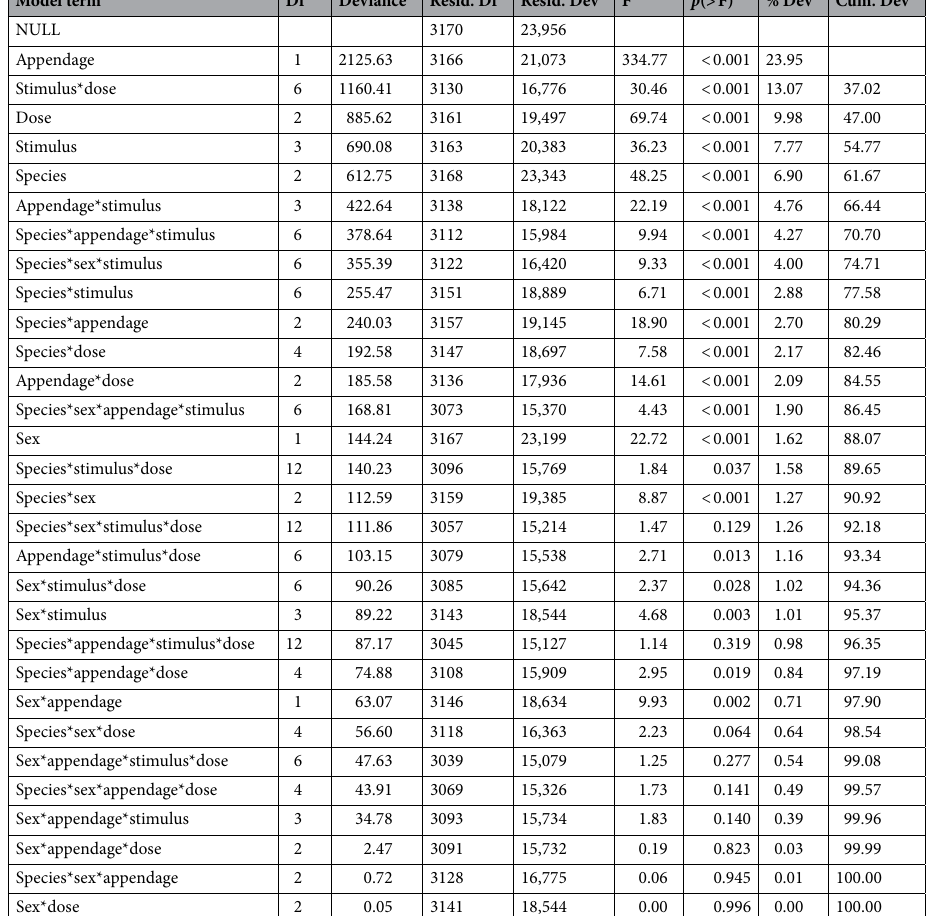
Table 2. Summary of the GLM model for the effect of species ( C. pomonella , G. molesta and L. botrana ), sex, stimulus (fructose, sucrose, NaCl and KCl), dose (10^1, 10^2, 10^3 mM), and appendage (antenna or labial palp) on the number of action potentials of sensilla chaetica. Terms have been ordered by their contribution to the model deviance (%